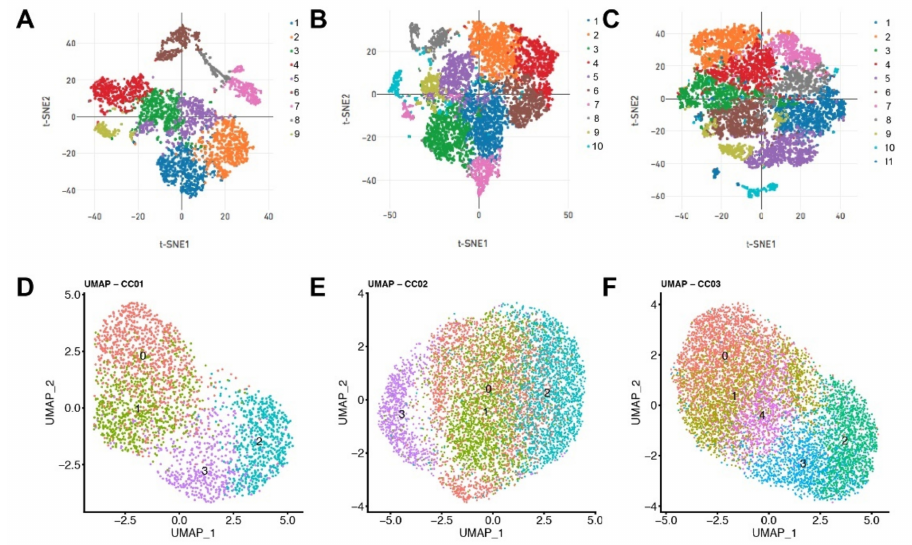
Figure 6. Dimensionality reduction of scRNAseq data. The t-SNE plot analysis of scRNAseq data prior to cell cycle regression ( A ) from patient1, ( B ) from patient2, and ( C ) from patient3. The Uniform Minifold Approximation and Projection (UMAP) plot analysis after cell cycle regression ( D ) from patient1, ( E ) from patient2, and ( F ) from